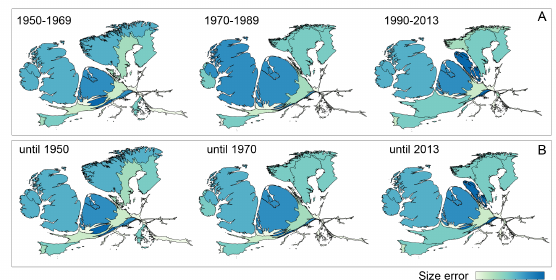
Figure 5: Cartogram of plant species occurrences at different dates, considering different periods (A) and cumulated data (B). Extracted from GBIF data (website accessed December